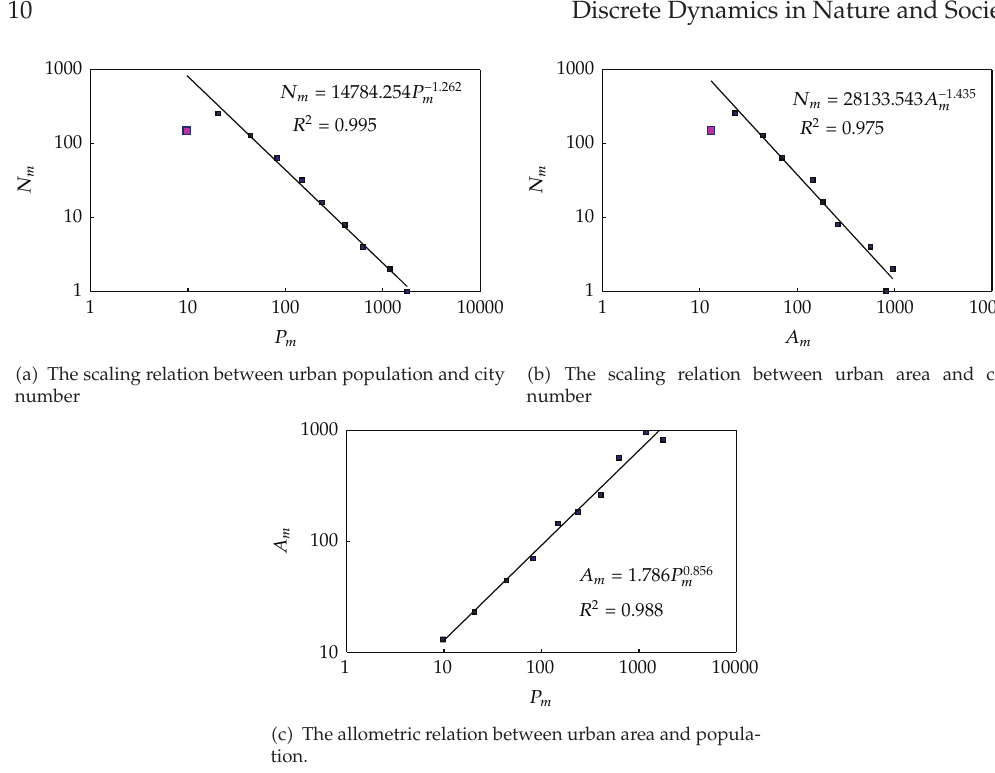
Figure 3: The scaling patterns for the hierarchy of 660 cities in China (cid:6) 2005 (cid:7) . (cid:6) Note: In the first two plots, the data points of the lame duck classes are treated as the outliers, which deviates from the normal scaling range because the small cities in China are of undergrowth (cid:7)